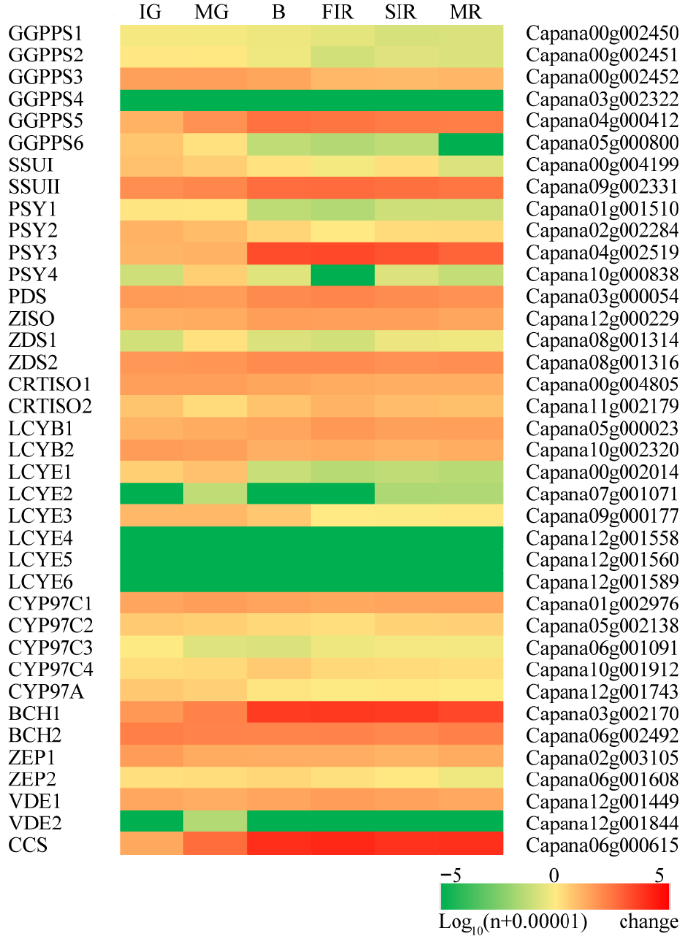
Figure 4. Expression levels of each of the genes for carotenoid metabolism at different ripening stages. B, breaker; FIR, first immature red; IG, immature green; MG, mature green; MR, mature red; and SIR, second immature red. Logarithms of the reads per kilobases per million reads (RPKM) value of each gene (plus 0.0001) are presented. Abbreviations for enzymes are BCH, β -carotene hydroxylase; CCS, capsanthin/capsorubin synthase; CRTISO, carotene isomerase; CYP, cytochrome P450; GGPPS, geranylgeranyl diphosphate synthase; LCYB, lycopene β -cyclase; LCYE, lycopene ε -cyclase; PDS, phytoene desaturase; PSY, phytoene synthase; SSU, small subunit homolog of GGPPS; VDE, violaxanthin de-epoxidase; ZEP, zeaxanthin epoxidase; ZDS, ζ -carotene desaturase; and Z-ISO, ζ -carotene isomerase. Accession numbers of all genes are provided in Table S5.